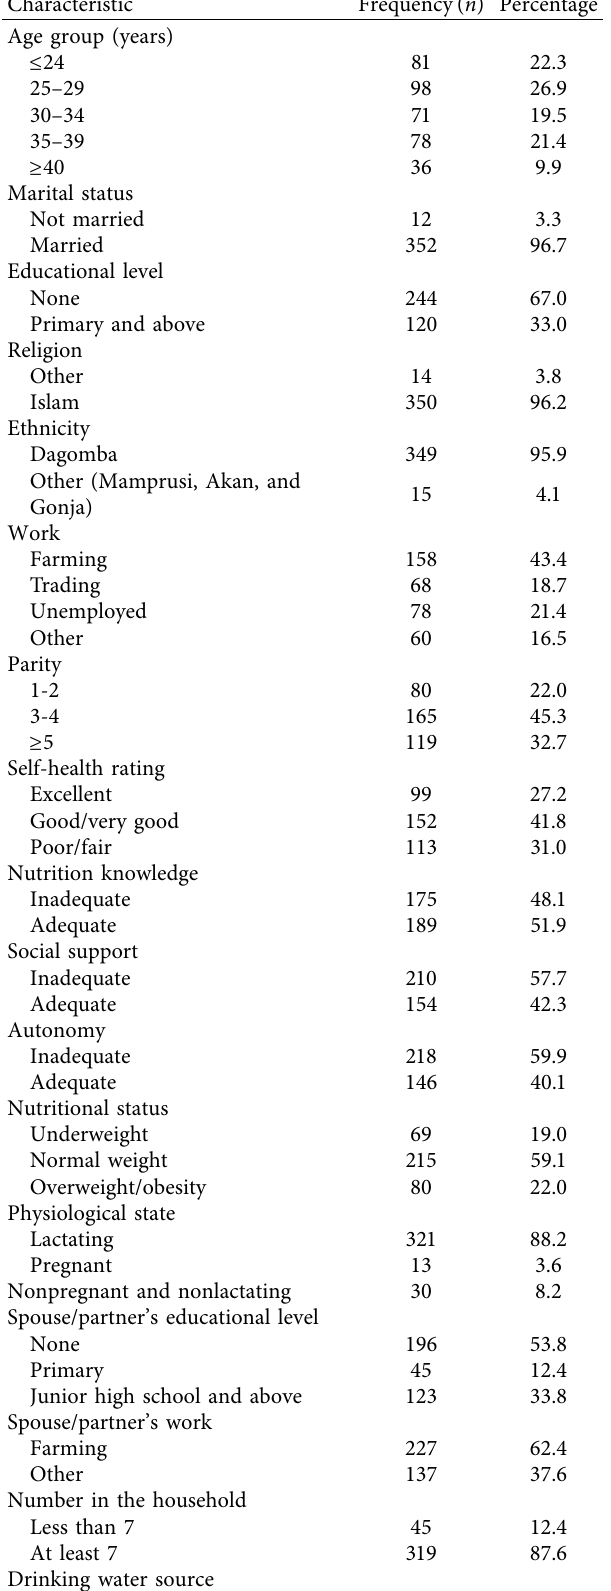
Table 1: General background characteristics of